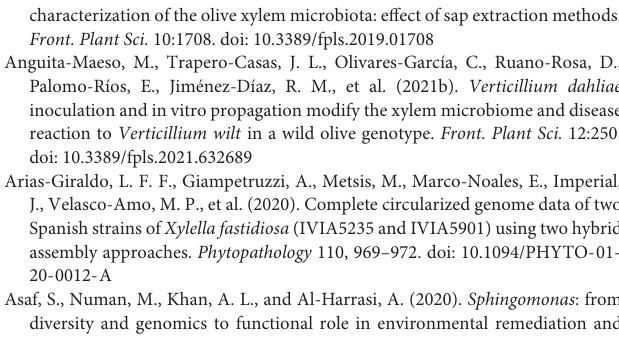
Supplementary Figure 1 | Linear regression between log [ Xylella fastidiosa reads] obtained by next-generation sequencing (NGS) sequencing and Cq values from the quantitative polymerase chain reaction (qPCR) protocols of Francis et al. (2006) and Harper et al. (2010) obtained from DNA extracted from xylem samples of X. fastidiosa -infected almond trees. Supplementary Figure 2 | Principal coordinate plots of Bray–Curtis and weighted UniFrac distances of bacterial (A,B) and fungal communities (C) at the amplicon sequence variant (ASV) taxonomic level in the xylem of Xylella fastidiosa –qPCR negative and positive almond trees sampled in each orchard in Alicante province. X. fastidiosa ASVs were maintained (A) or removed (B) from the data set before analysis. Points are colored by X. fastidiosa detection. Supplementary Figure 3 | DESeq2 analysis of differentially enriched bacterial genera present in the xylem of Xylella fastidiosa –qPCR negative and positive almond trees in the different sampled orchards in Alicante province. The color scale bar indicates log2 fold change. Only significant genera ( p < 0.05) are shown. Supplementary Figure 4 | DESeq2 analysis of differentially enriched fungal genera present in the xylem of Xylella fastidiosa –qPCR negative and positive almond trees in the different sampled orchards in Alicante province. The color scale bar indicates log2 fold change. Only significant genera ( p < 0.05) are shown. Supplementary Figure 5 | Co-occurrence network inference plot of bacterial and fungal communities (A) present in the xylem of almond trees with the presence (B) or absence (C) of Xylella fastidiosa ASVs in the data set before analysis. Copresence (green) and mutual exclusion (red) are shown as the edges between the